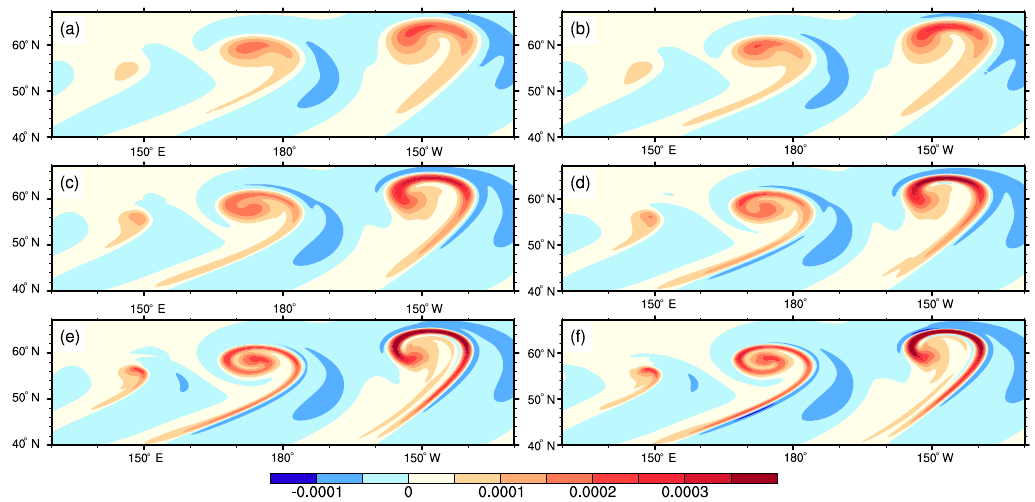
Figure 3. Day 9 relative vorticity at 850hPa in the baroclinic instability test. Left column – SL-AV20 solutions using regular lat–lon grids with constant latitude resolution: (a) 400 × 250, (c) 800 × 500, (d) 1600 × 865. Right column: (b) , (d) , (e) – the same as the left column, but using reduced lat–lon grids with variable resolution in latitude.